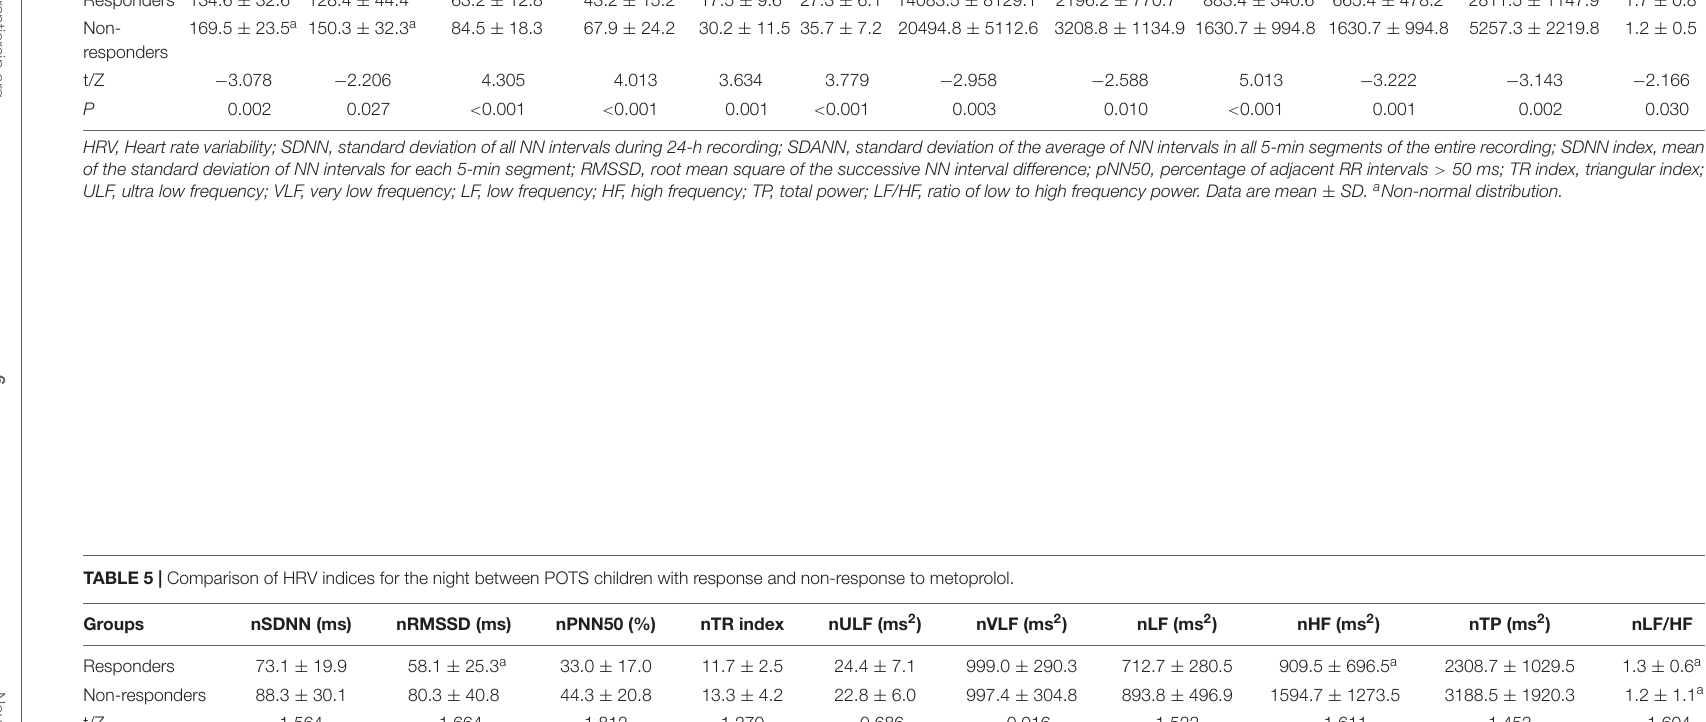
TABLE 4 | Comparison of HRV indices between POTS children with response and non-response to metoprolol. Groups